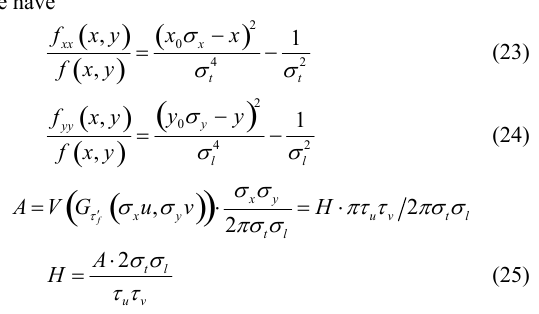
Figure 5 QE estimation of posion when Sinc peak is at x =0.6, y =0.1 with 10dB noise We can then use QE algorithms to detect parameters of peak.